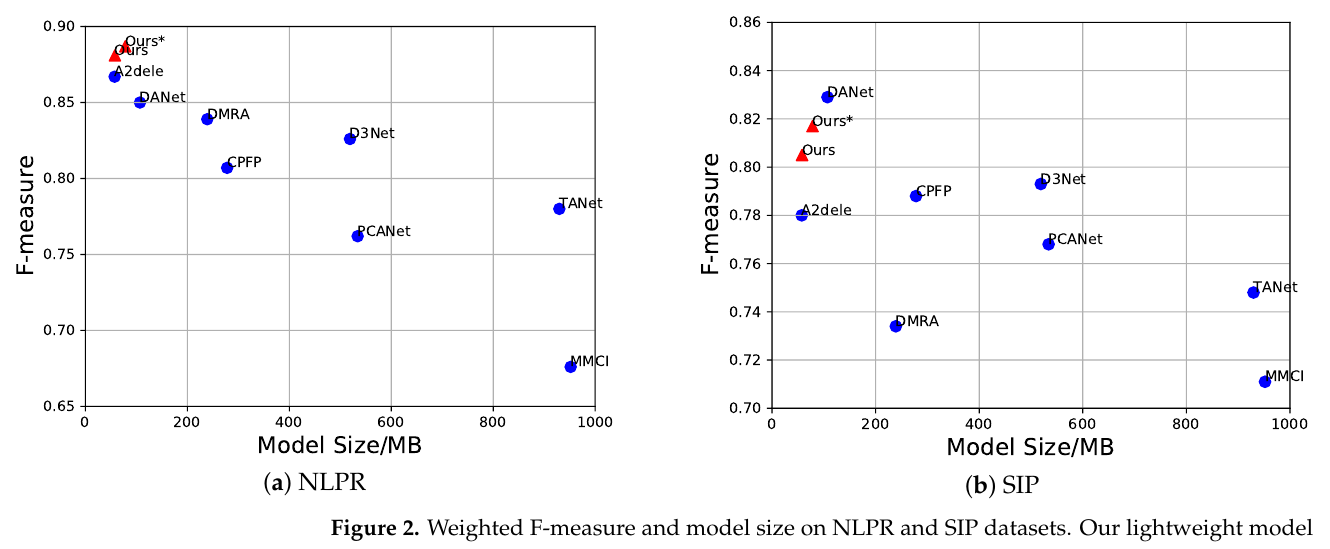
Figure 2. Weighted F-measure and model size on NLPR and SIP datasets. Our lightweight model with simple early fusion can achieve satisfactory detection results over different datasets. Ours and Ours* indicate simple VGG16-based and VGG19-based FPN,